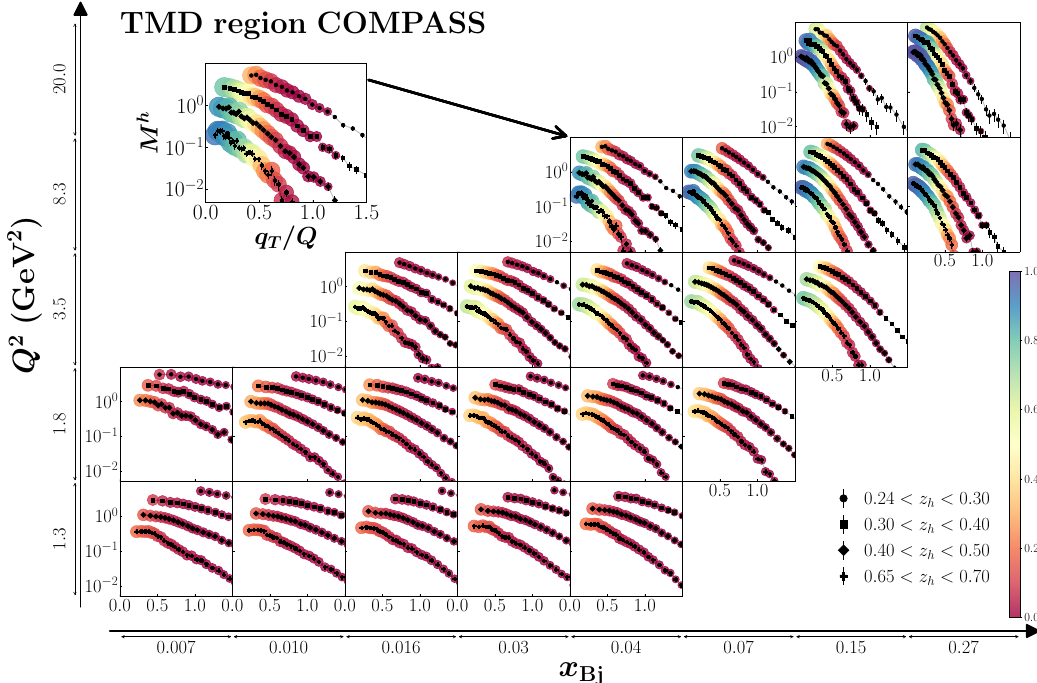
Figure 7 . TMD region for COMPASS data [45] on multiplicities M h for hadrons h + (black sym- bols) produced in muon-deuteron SIDIS, as a function of q bins in z , with the dataset at the top (bottom) corresponding to the lowest (highest) range in z h TMD affinity for low values of P TMD affinity, as seen in figure